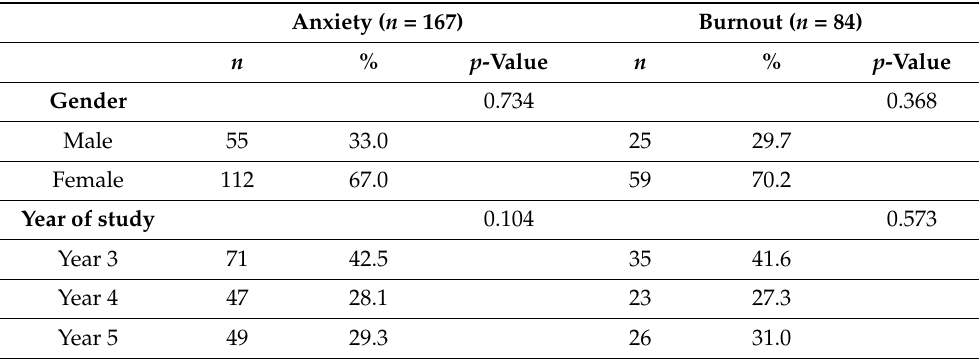
Figure 1. Prevalence of anxiety and burnout among clinical year medical undergraduate students in UKM during the COVID-19 pandemic. Table 2. Association of psychological distress with sociodemographic characteristics among the